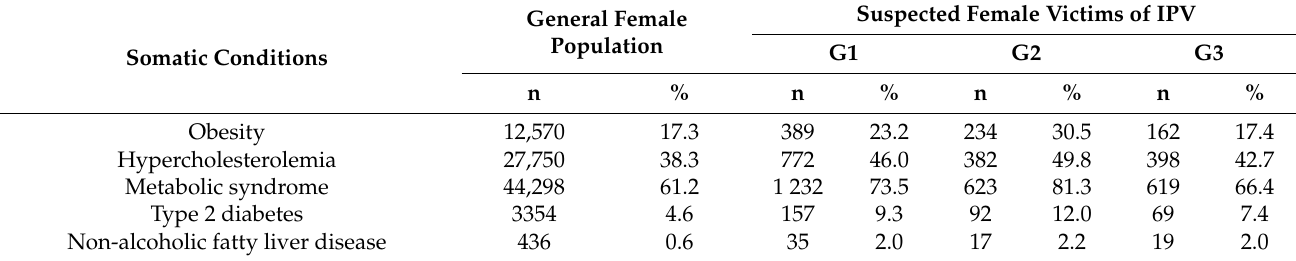
Table 5. Victims’ somatic